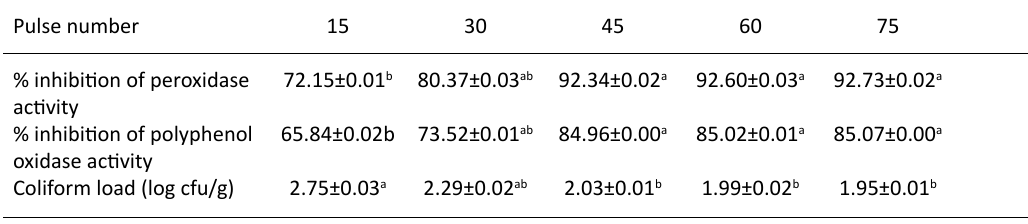
Values are the average of triplicate; numbers in row accompanied by the alike symbols are not varied significantly (α =